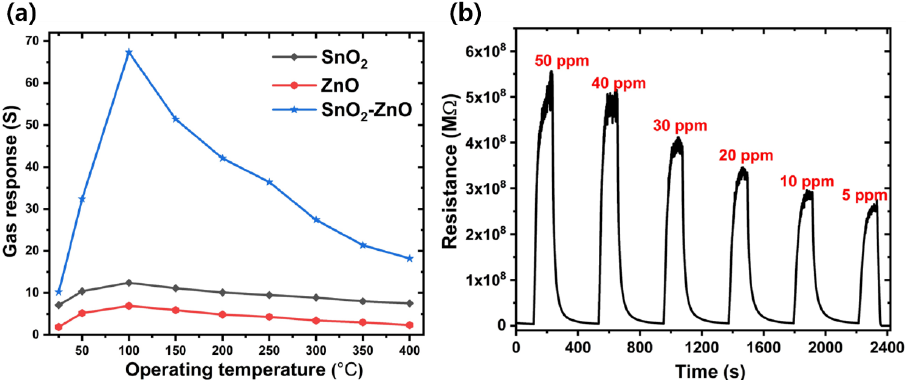
Figure 5. ( a ) Evaluation of gas response for SnO 2 , ZnO, and SnO 2 / ZnO heterostructures at various operating temperatures, ( b ) response curves of SnO 2 /ZnO heterostructures towards NO 2 concentration of 5 – 50 ppm.